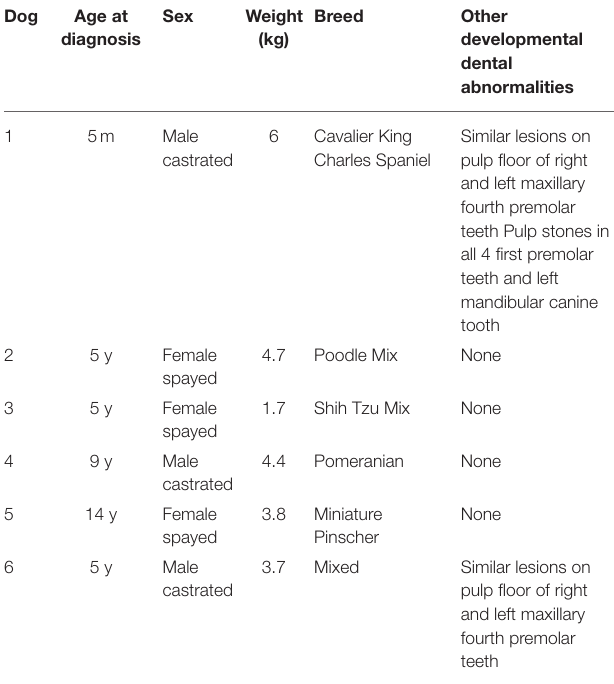
TABLE 1 | Summary data for 6 dogs with developmental abnormalities of the mandibular first molar teeth.